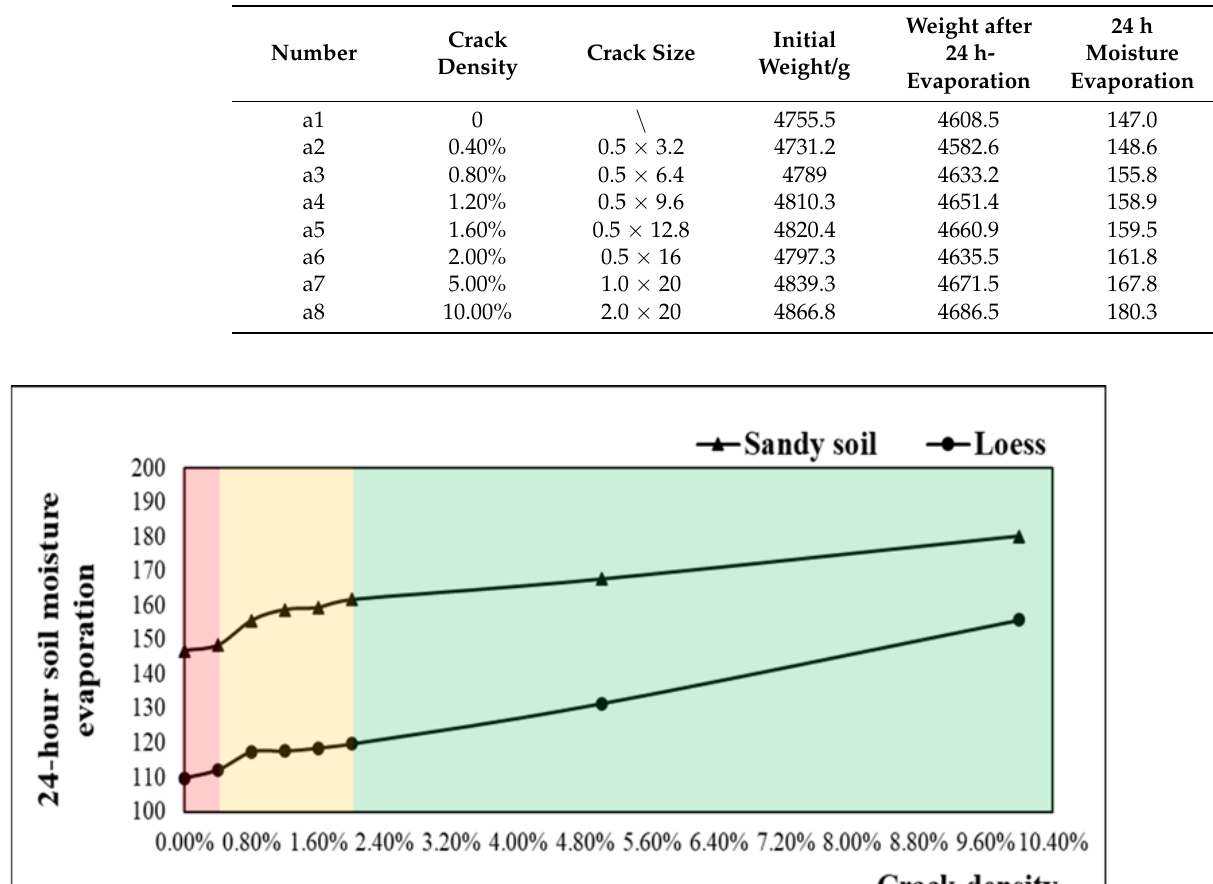
Table 4. The experimental results for moisture evaporation from sandy soil under different crack densities in 24 h.